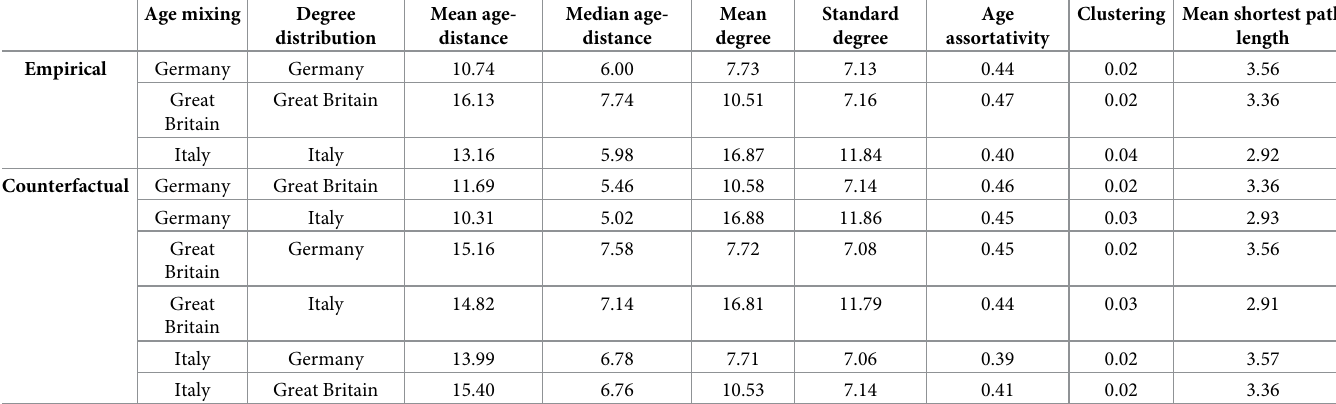
Table 2. Descriptive statistics of simulated networks, based on population age distribution of Italy (UN data). Age mixing Degree